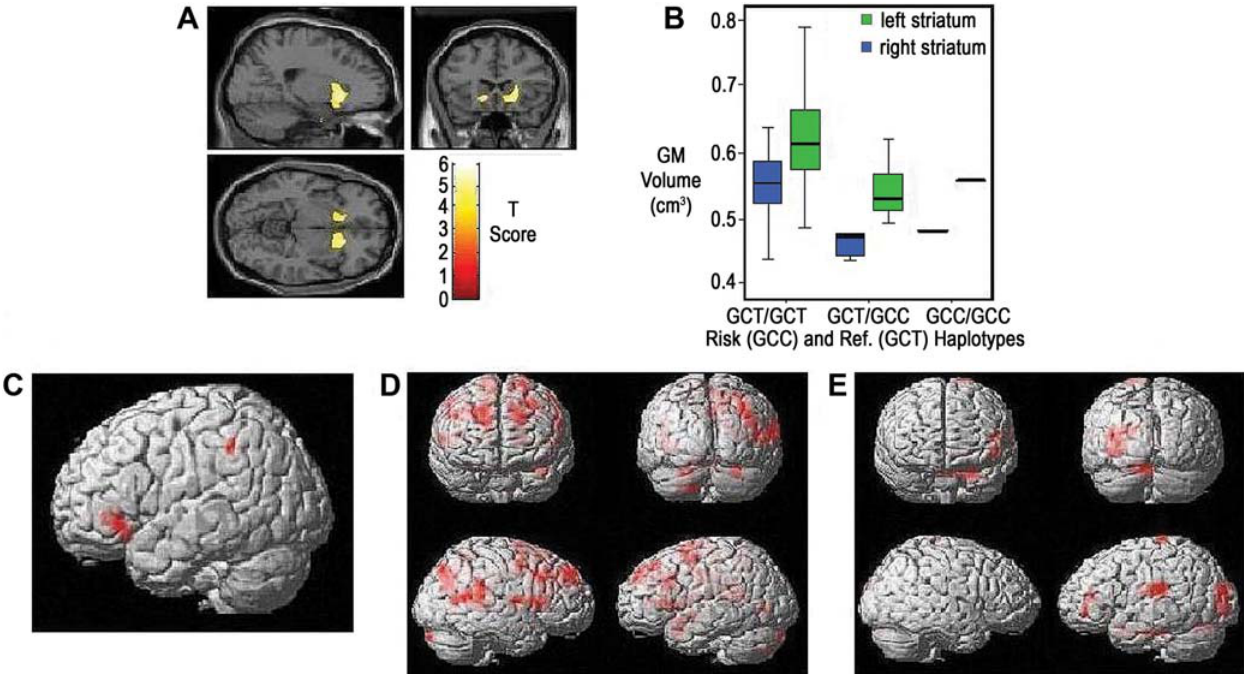
Figure 2. Risk and Reference haplotypes: multimodal imaging results (see supplemental tables for results surviving multiple comparison correction). A) Decreases in grey matter volume for risk haplotype carrier in relationship to the reference haplotype, at p , 0.001 uncorrected threshold. B) Extracted striatal cluster grey matter values plotted by haplotype. C) Areas of relatively decreased BOLD signal for risk haplotype vs. reference effect on the working memory network in normal subjects in the working memory network visualized at uncorrected p , 0.001 (VLPFC) k=13 Z=3.39, p , 0.045 small volume corrected for VLPFC (45, 2 45, 42) k=31 Z=3.81, p , 0.043 small volume corrected BA 40. Df) Area of relatively increased and E) decreased striatal connectivity for the risk haplotype at uncorrected p , 0.05. Statistical mappings are overlaid on a single subject T1 images. Statistical results after multiple comparison correction shown in Tables S1, S2 and S3.